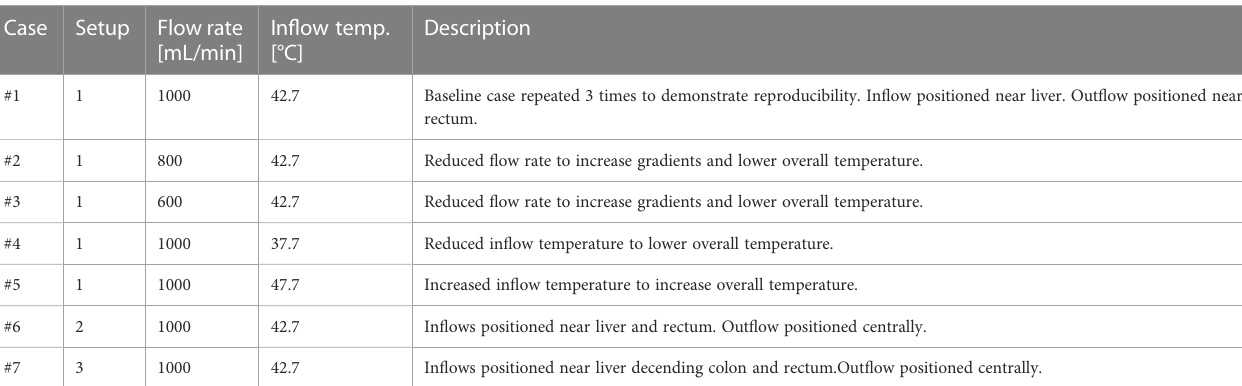
TABLE 1 Catheter setup and fl ow rates considered in this study.